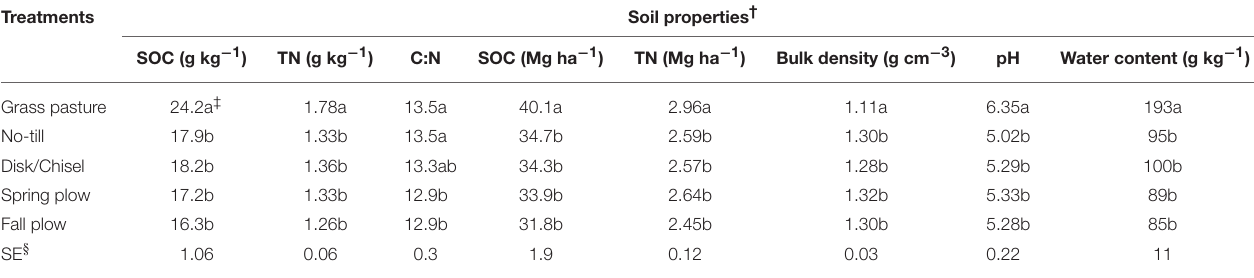
TABLE 1 | Treatment effects on bulk soil characteristics in 0- to 15-cm Walla-Walla silt loam near Pendleton, Oregon. Treatments Soil properties †